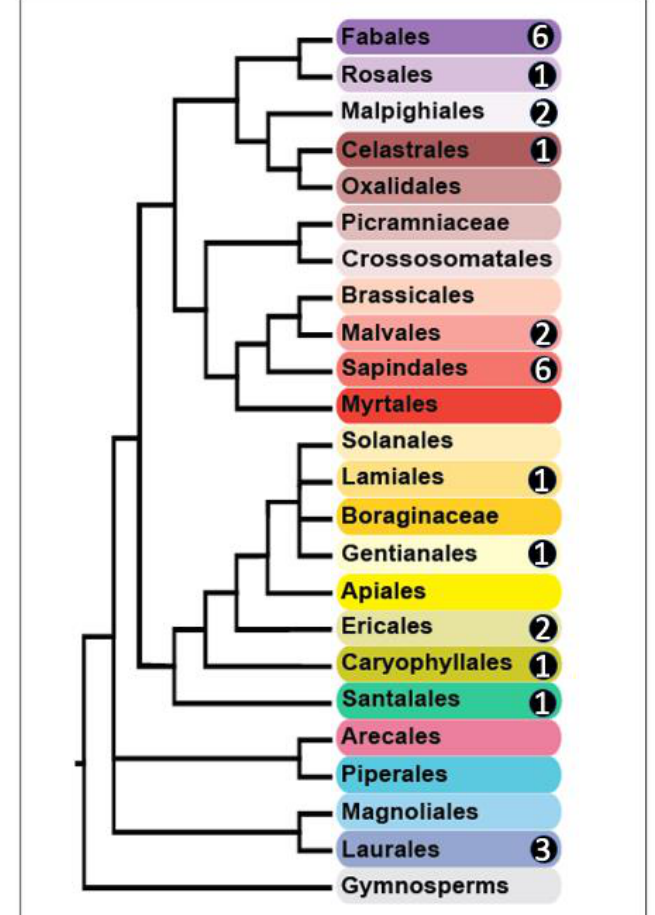
Figure 3. The phylogenetic distribution of plant species in the diets of katydids on BCI. The evolution- ary relationships of the 23 orders of flowering plants found on BCI are represented in the branching diagram (modified from Figure 1 in [39]; see Figure S1 for a full representation of the species diversity of trees in the 50-ha forest dynamics plot). Circled numbers indicate the number of host plant species per order detected in the gut contents of katydids, as determined by DNA barcoding. Most katydid species were consuming plant species that could grow into the canopy layer (Figure 4). However, some katydid species were foraging on plants that never grow higher than the